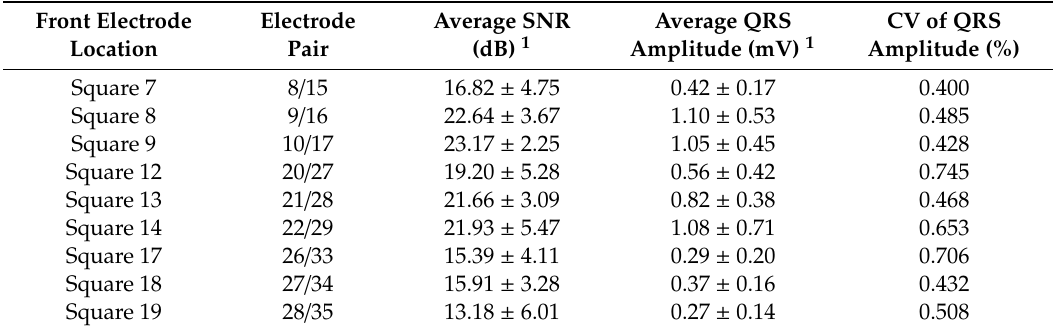
Table 4. Comparison of channel 5 among the nine squares in Fine-grained step.